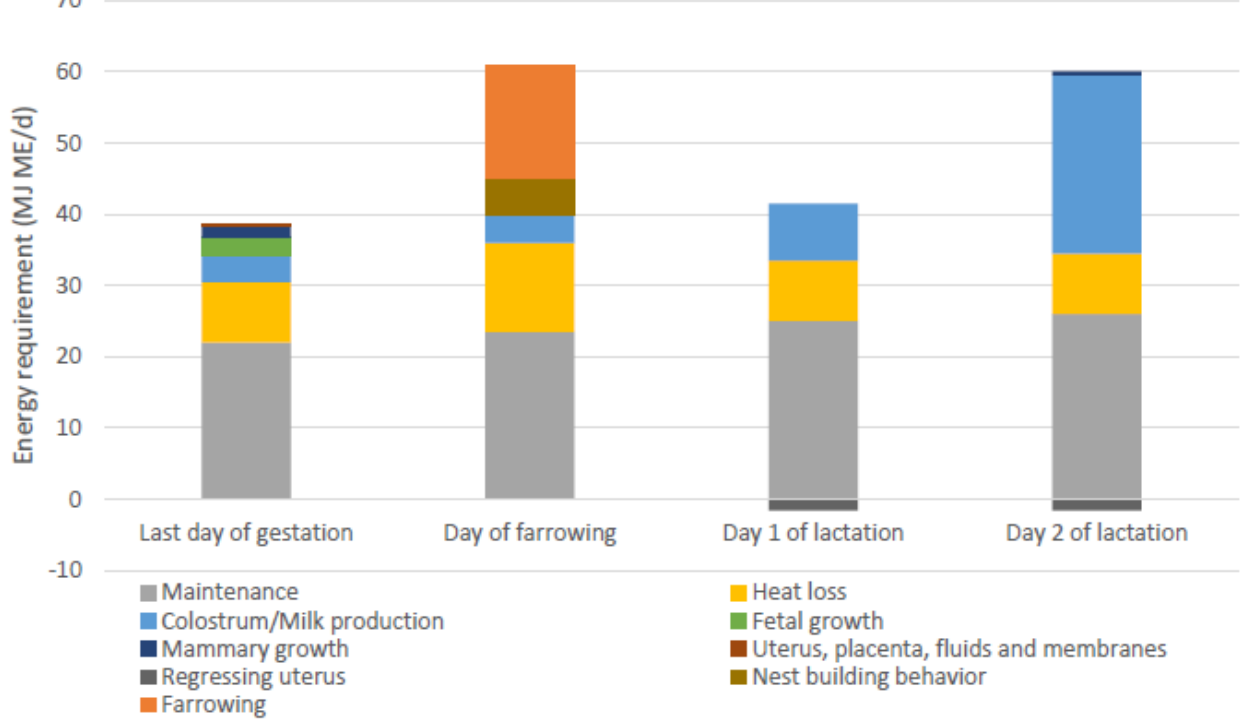
Figure 4. Energy requirements of sows on the last day of gestation, the day of farrowing, and day 1 and 2 of lactation, adapted from [59], including estimated energy requirements for additional heat loss, nest building behaviour and farrowing [81]. ME = metabolizable